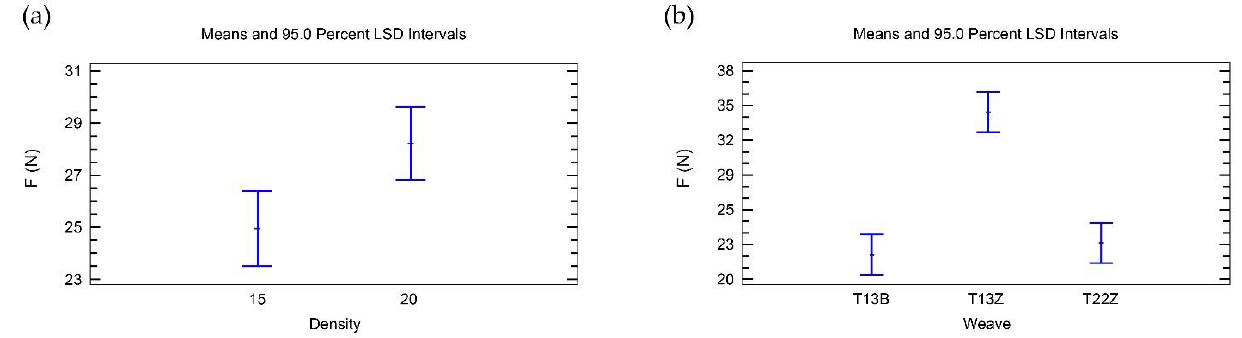
Figure 4. Influence of the main factors on the adhesion force for simple fabrics for z2: ( a ) density; ( b ) weave.